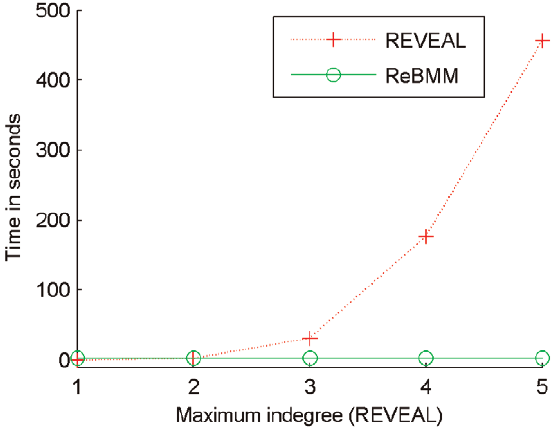
Figure 13. Comparison of running time of REVEAL and ReBMM. ReBMM’s running time is independent of the maximum indegree of nodes in the network. REVEAL’s running time increases markedly with the increase in the assumed